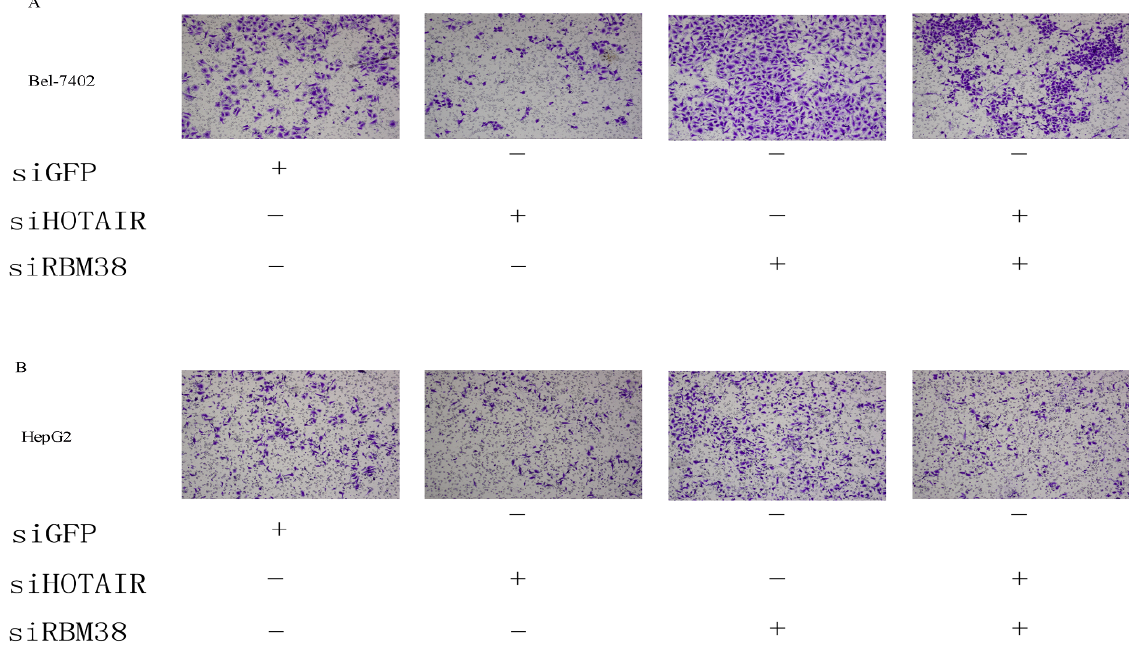
Figure 7. Knockdown of RBM38 restored the HOTAIR siRNA-mediated inhibition of invasion in Bel-7402 cells ( A ) and HepG2 cells ( B ). The number of invaded cells was measured. The representative invasion images are shown at 100×